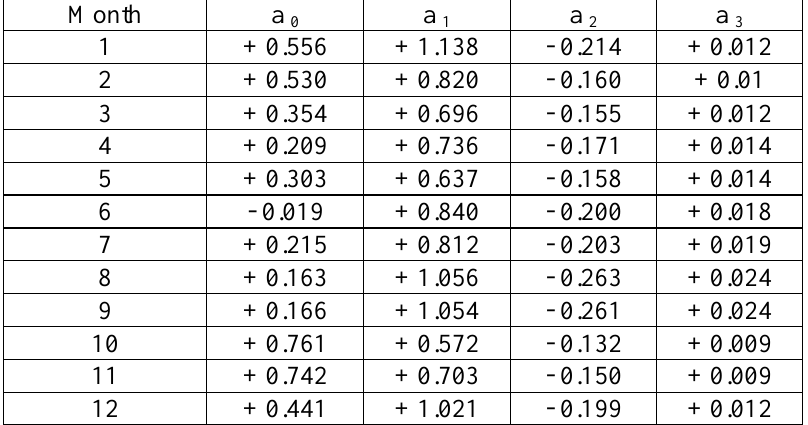
/N ) with days of year mp e